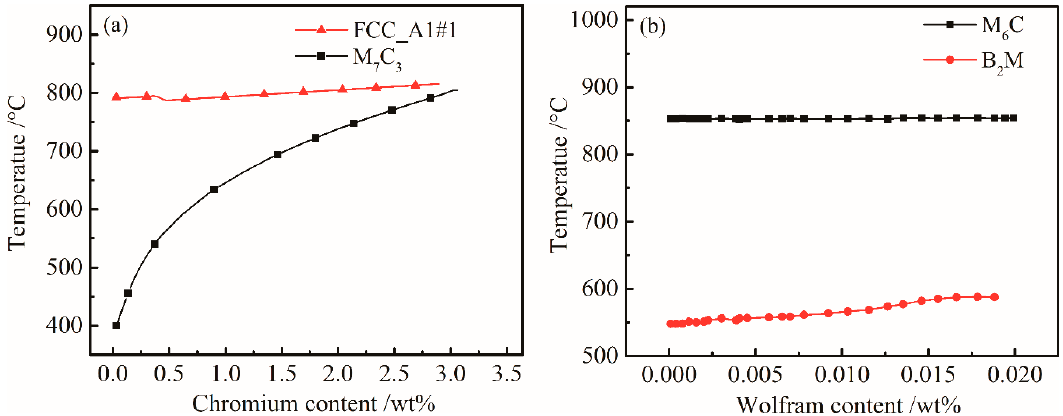
Figure 3. Influences of ( a ) Cr and ( b ) W content on the equilibrium phase diagram of the bainitic steel.